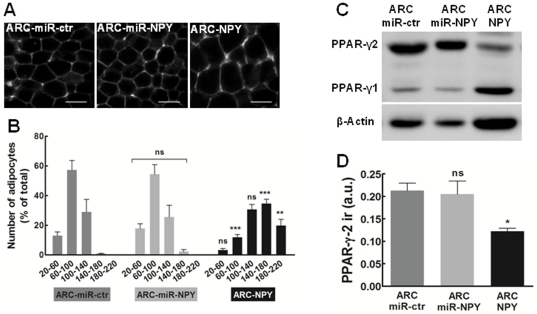
ARC NPY overexpression increases adipocytes size and decreases PPAR-gamma-2 adipogenic marker in white adipose tissue.Evaluation of adipocytes size and differentiation markers (Peroxisome Proliferator Activated Receptor type 2, PPAR-gamma-2), eight weeks after AAV injection. (A) Representative images of adipocytes auto-fluorescence from ARC-miR-ctr, ARC-miR-NPY and ARC-NPY groups. Scale bar, 100 µm. (B) Adipocytes size distribution represented as percentage of total number of adipocytes. n = 6 rats per group; ns, non-significant, ** p<0.01; *** p<0.001 compared to ARC-miR-ctr group size range. (C) Evaluation of PPAR-gamma isoforms in epididymal adipose tissue extracts by immunobloting. Representative images of protein level. The expression of PPAR-gamma-2 isoform is lower on ARC-NPY obese rats, compared to ARC-miR-ctr rats. (D) Densitometry band evaluation normalized to β-actin and shown as percentage of ARC-miR-ctr. n = 3/4 rats per group; ns p>0.5; * p<0.5, compared to ARC-miR-ctr group. ir, immunoreactivity.